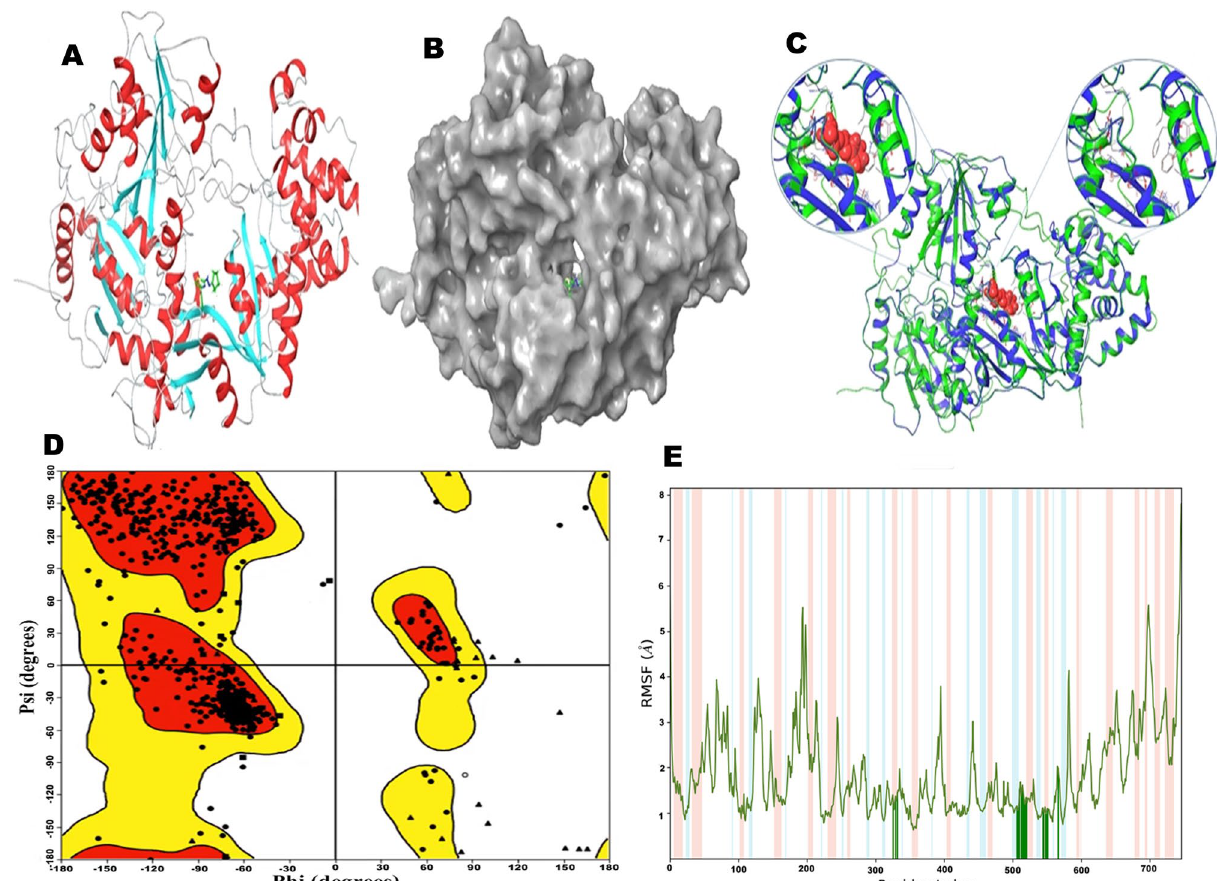
Figure 1. 3D structure of human NAT10 generated model with Remodelin. ( A ) Model chains of human NAT10 in different colors with Remodelin in its active site. ( B ) Solid model of human NAT10 showing the active site groove containing Remodelin. ( C ) Superposition of the human NAT10 model (green) and the structure of template tRNA (Met) Cytidine Acetyltransferase (PDB ID: 2ZPA) (white), with enlarged active site pocket and residues interacting with Remodelin. ( D ) Ramachandran plot of human NAT10 generated model. Red and yellow are allowed regions. Triangles indicate glycine, squares are proline, circles indicate other amino acid residues on the protein. ( E ) The Root Mean Square Fluctuation (RMSF) plot of human NAT10 protein, peaks indicate the fluctuation of human NAT10 during simulation, and the green-colored vertical bars indicate acetyl- CoA binding site residues interacting with